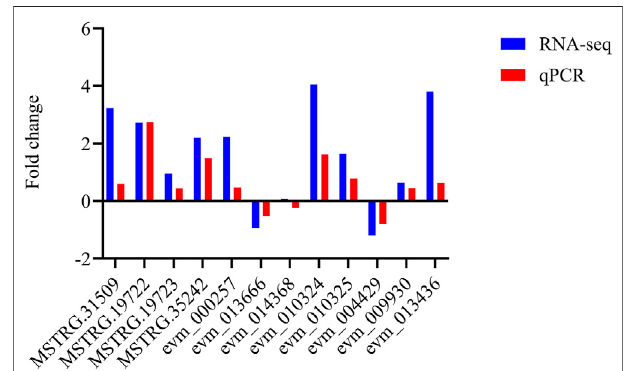
FIGURE 6 | Expression of twelve randomly selected genes validated by qPCR. Validation of RNA-Seq data by qPCR. Twelve candidate genes were randomly selected for quanti fi cation. Column height is proportional to fold change of gene expression. Fold change is positive for upregulated genes and negative for downregulated genes. Values are